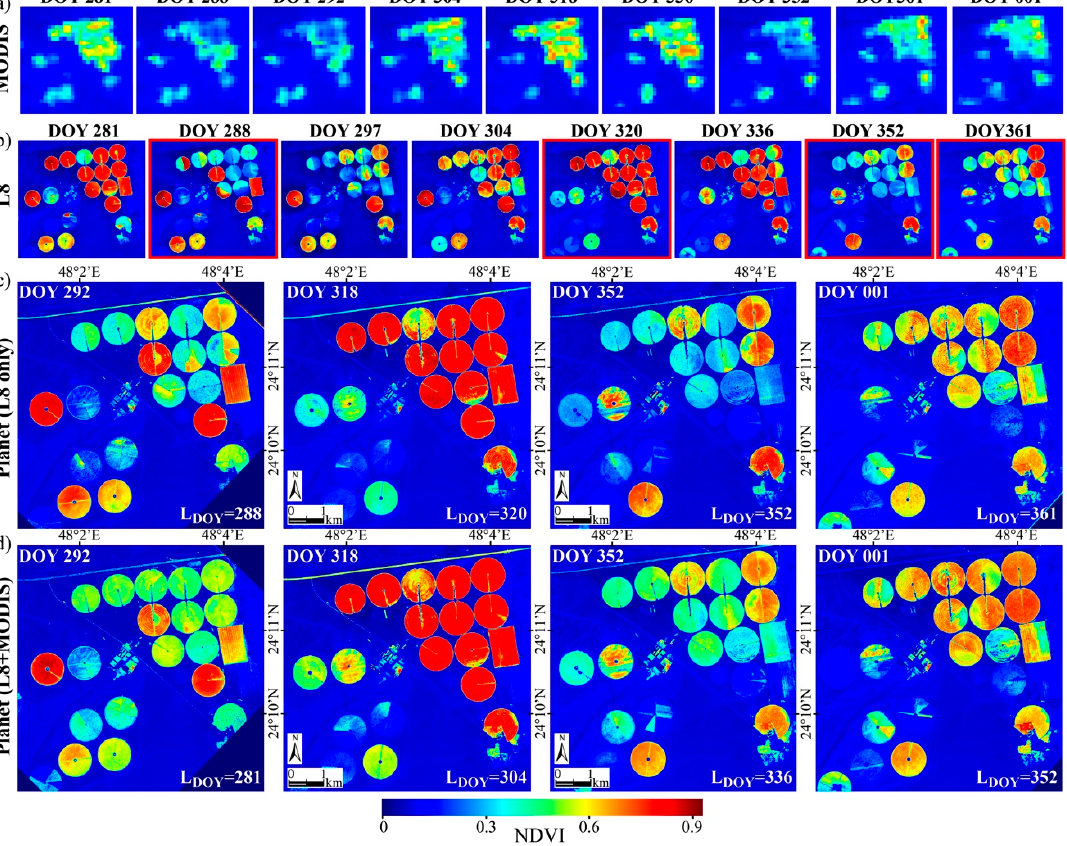
Figure 6. Time-series of ( a ) 250 m resolution MODIS; ( b ) 30 m resolution Landsat-8; and ( c , d ) 3 m resolution Planet NDVI over a subset of the farm. In ( c ), NDVI was predicted on the basis of a near-coincident (i.e., within 0–5 days) Landsat acquisition that is indicated by a red boundary box ( b ). In ( d ), the Landsat-8 NDVI image used as training base is within 11–16 days of the Planet acquisition, and MODIS NDVI is used to inform on the change occurring over these timespans. Table 3. Overall (i.e., Planet DOY 318, 352 and 001) NDVI prediction results on a cover specific basis. Results based on the Landsat-only (L8) and MODIS informed (M) processing streams are reported in separate columns (i.e., L8 and L8 + M). The statistics are based on Planet data resampled to 30 m, and are reported for the full set of data points (i.e., 99%). The number of pixel samples (n), and average NDVI and standard deviation of each cover type are also given.